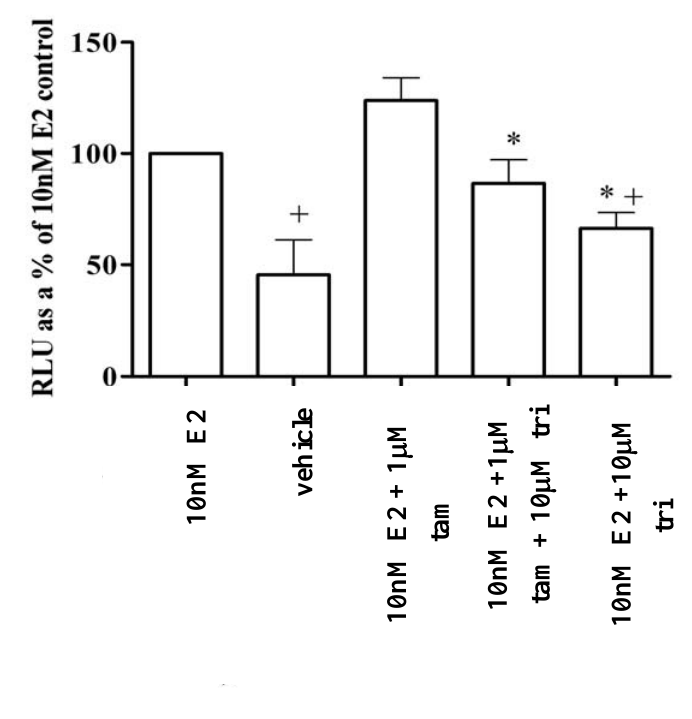
Figure 5. Trilostane inhibits oestrogenic activity of cells already stimulated with E2 and tamoxifen. Reporter activity was measured in the presence of combinations of stimulatory 10 nM E2, 10 μ M trilostane, with agonist/antiagonist properties, and 1 μ M tamoxifen, which is slightly inhibitory, and was expressed as a percentage of 10nM E2 control in MCF-7 cells. + indicates significant difference (P < 0.05) to 10nM E2 while * indicates significant repression (P < 0.05) compared to stimulation with E2 plus